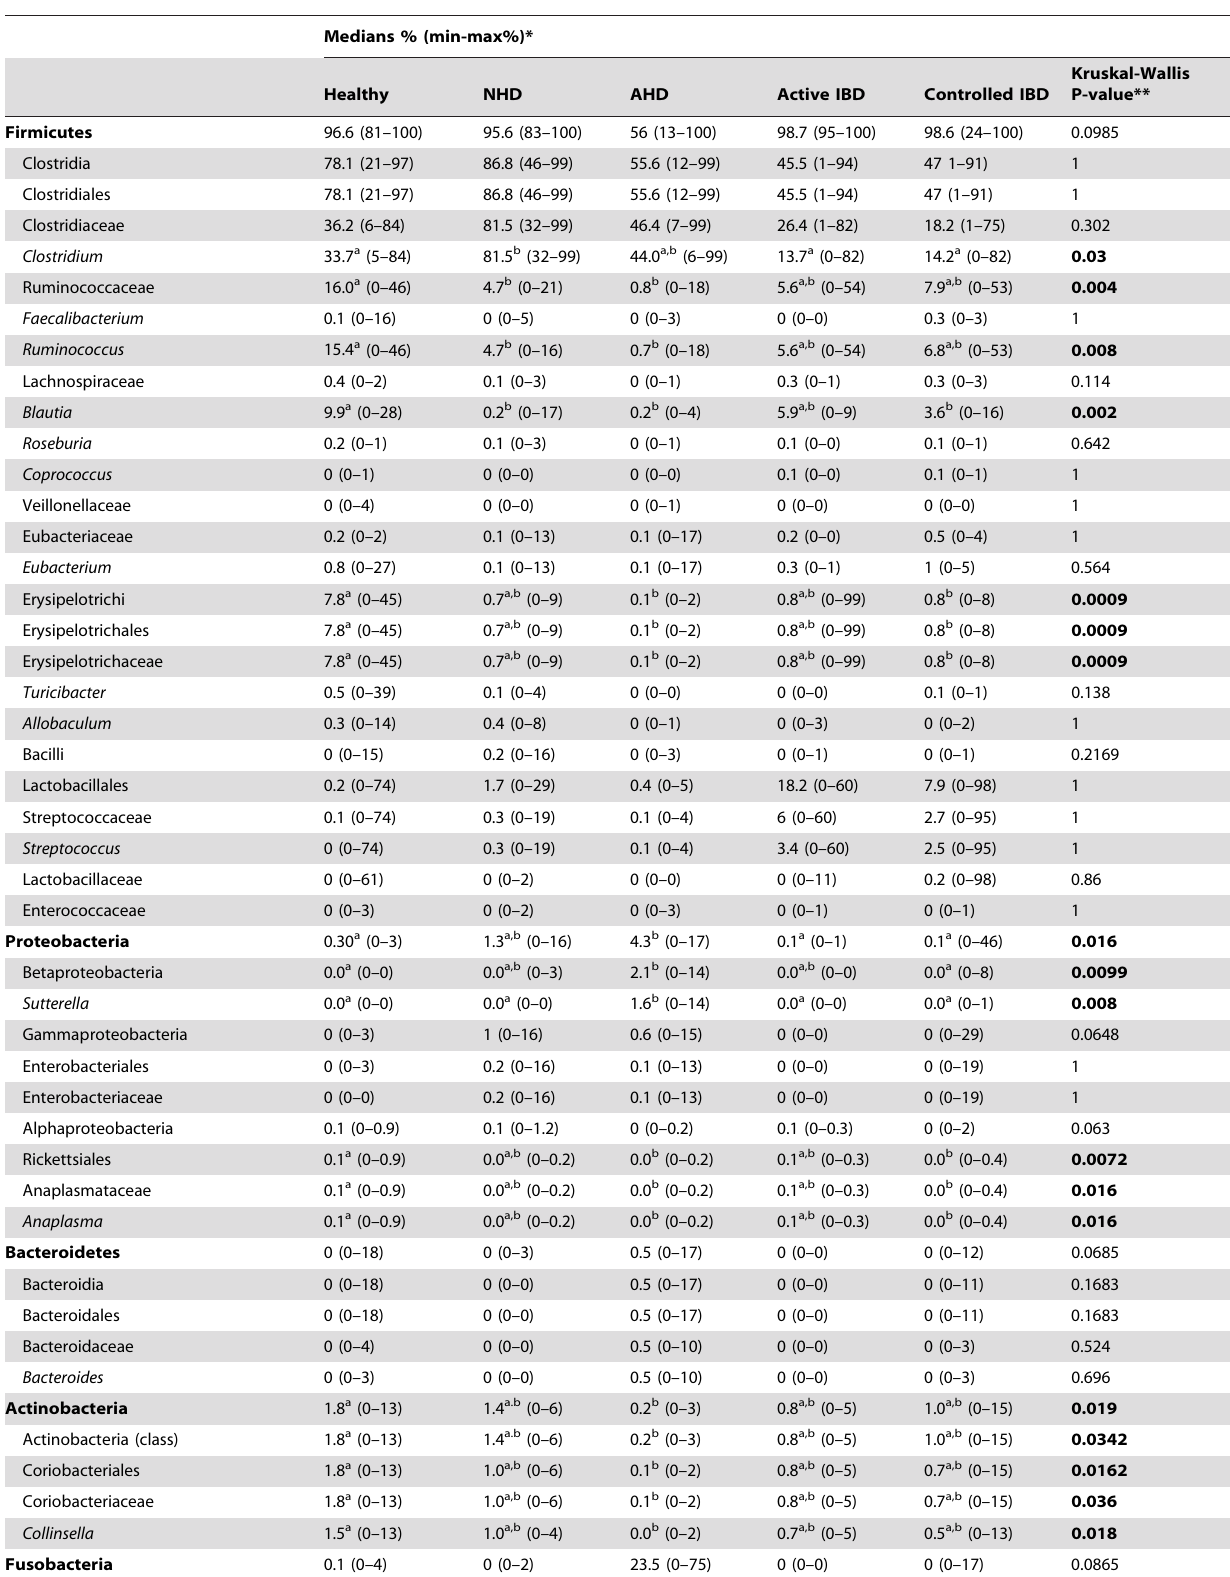
Table 3. Relative percentages of the most abundant bacterial groups at the various phylogenetic levels (phylum, class, order, family, genus) based on